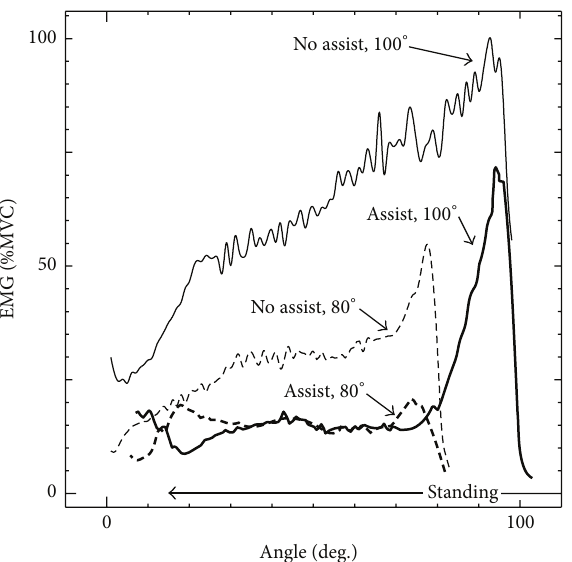
Figure 18: Muscle activation with and without